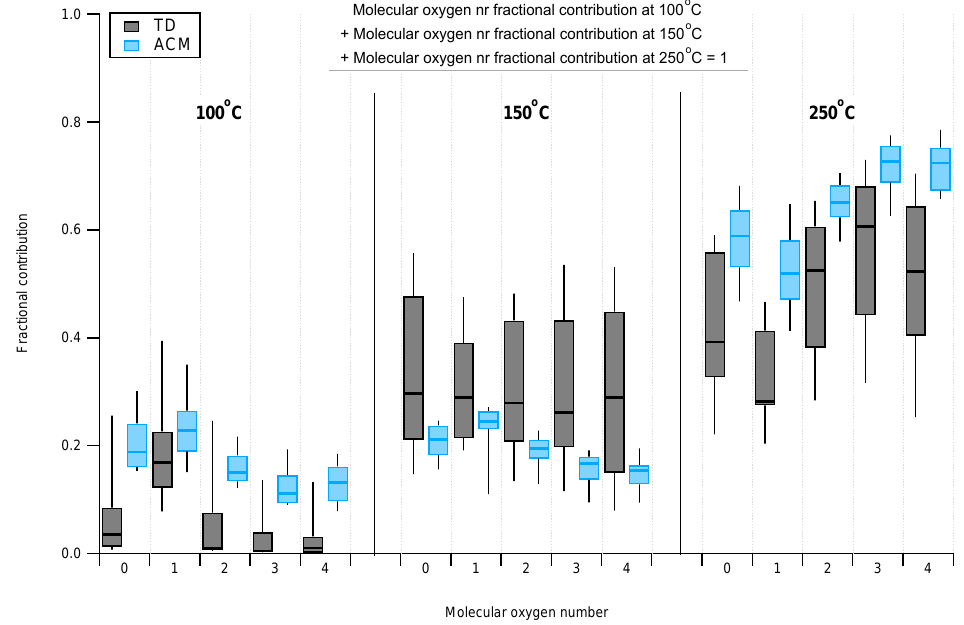
Figure 6. Box-and-whisker plots showing the distribution of the molecular oxygen number ( x axis), for the different temperature steps (100, 150, 250 ◦ C) of ACM (light blue) and TD (black). Each box and whisker corresponds to the median, 25th and 75th percentile levels of all desorption points throughout the campaign. Upper equation indicates how the contribution of each molecular oxygen number, at each temperature, corresponds to